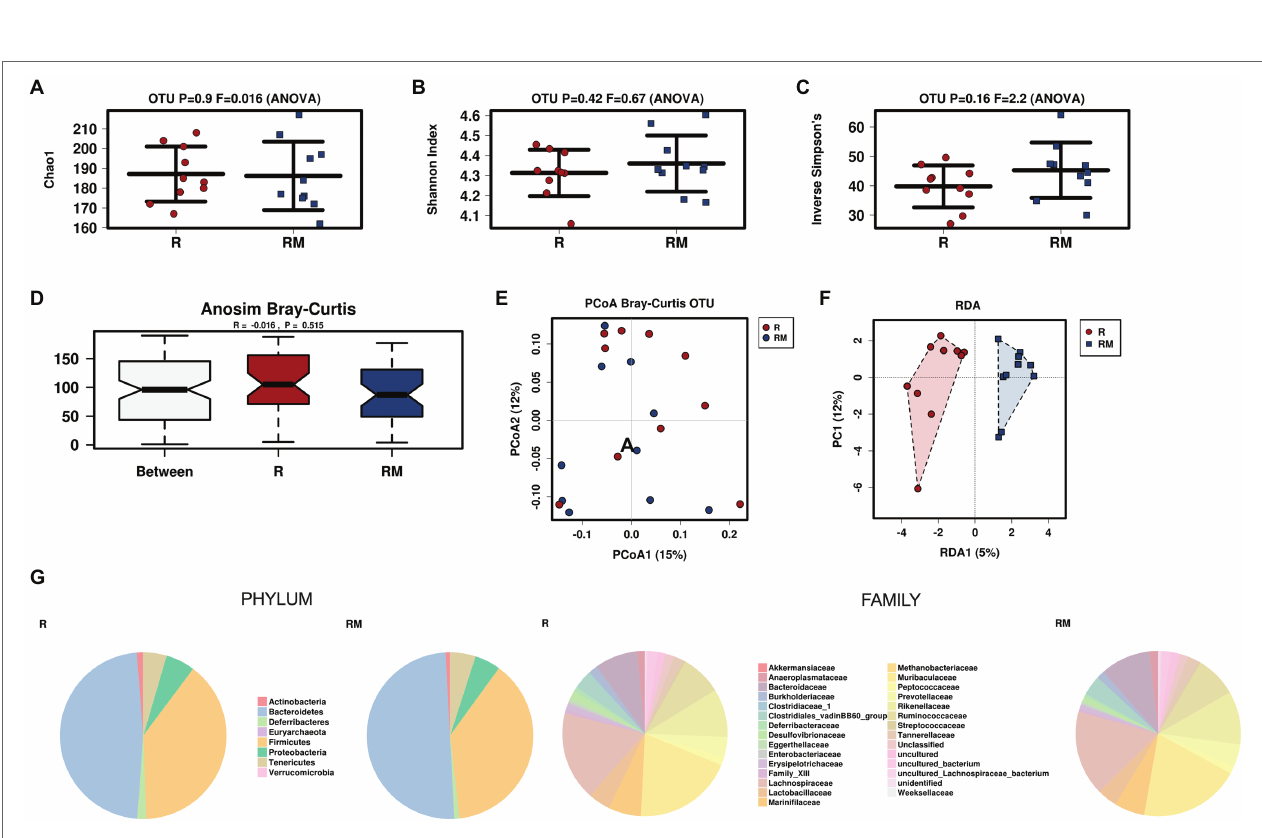
FIGURE 1 | (A–C) Results of antimicrobial resistance testing. Bars represent the median diameter in mm, whiskers the interquartile range (IQR) of the five samples.